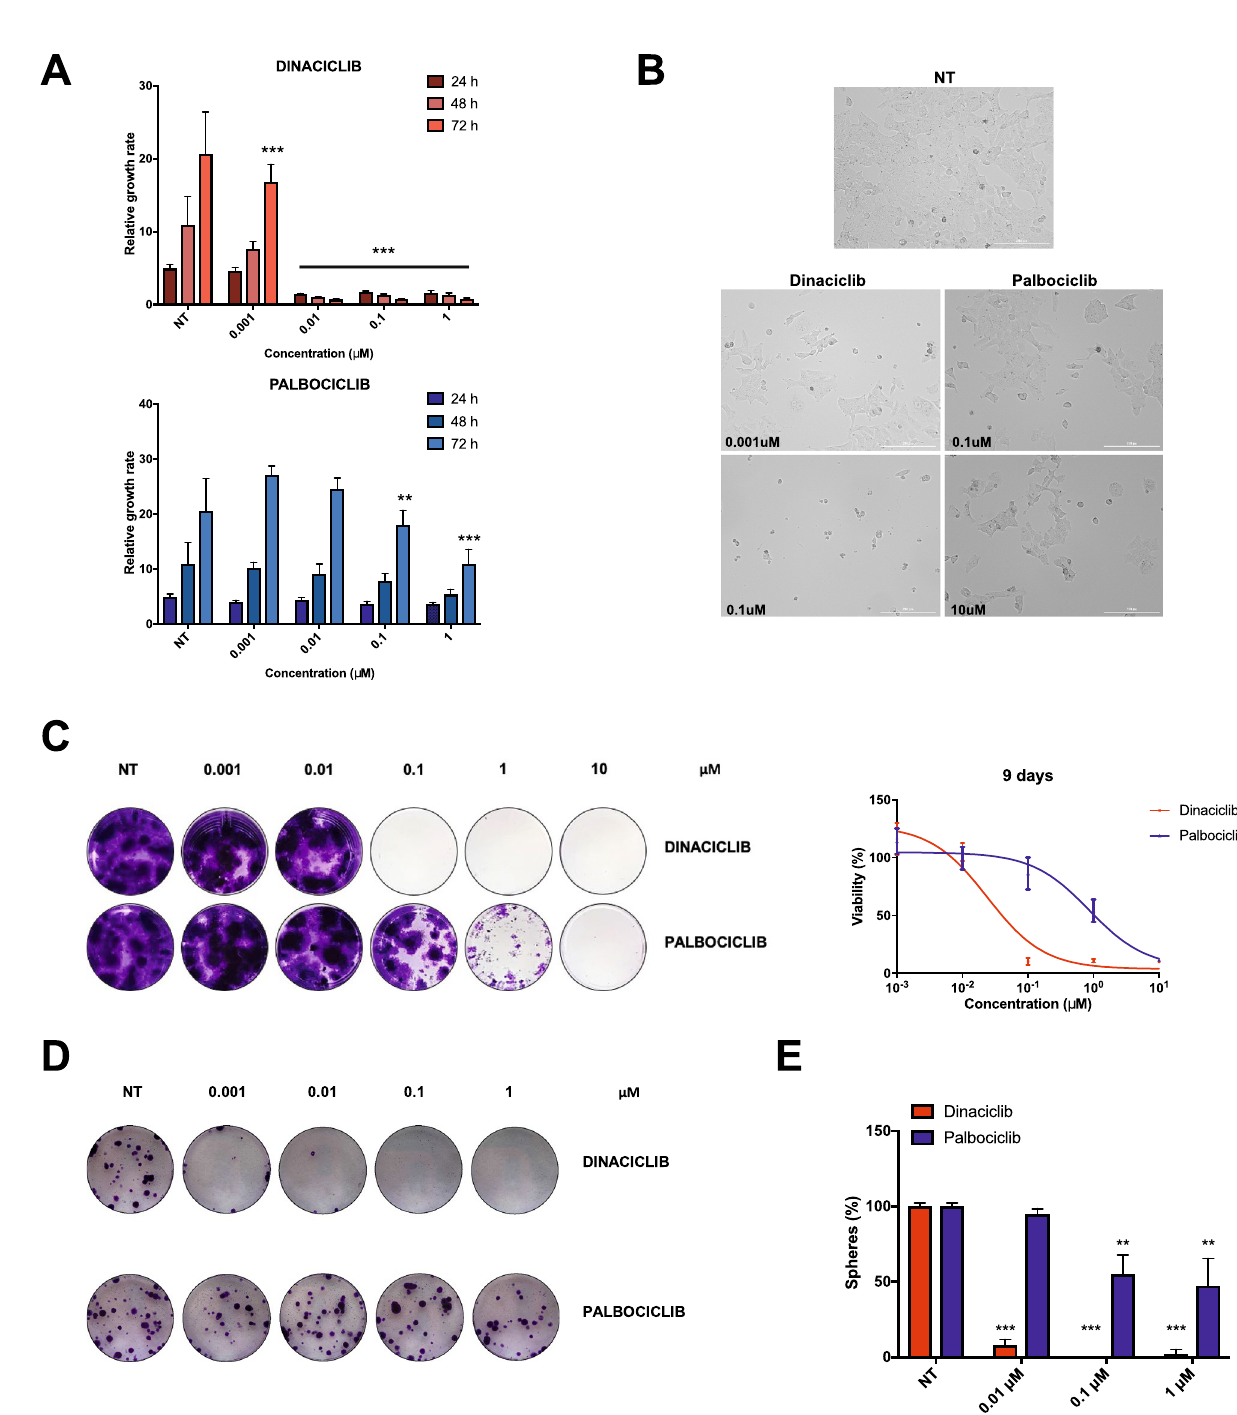
Figure 2. Dinaciclib shows stronger inhibitory responses than palbociclib in medulloblastoma. ( A ) Growth rates over 72 h of HD-MB03 cells treated with dinaciclib (top) or palbociclib (bottom) at the indicated concentrations. ( B ) Representative phase-contrast images of HD-MB03 cells treated with IC50 and 100xIC50 doses of dinaciclib and palbociclib for 72 h. Images were captured at 100 × total magnification. ( C ) Representative crystal violet staining images of long-term proliferation assay. HD-MB03 cells were treated with the indicated drugs for 9 days and then fixed and stained. On the right, crystal violet quantifications relative to the presented images. ( D ) Representative crystal violet staining images showing resistant HD-MB03 colonies arising after dinaciclib and palbociclib wash-out over 12 days recovery. Pre-treatments with each drug were carried out over 24 h before wash-out. ( E ) Percentages of cell viability inhibition of HD-MB03 medullospheres after 72 h treatment with different doses of dinaciclib or palbociclib, calculated as relative to untreated control. Statistical comparisons were performed using an unpaired, two-tailed Student t-test where ** P < 0.01; *** P < 0.001. Plotted graphs show mean ± SD (n =